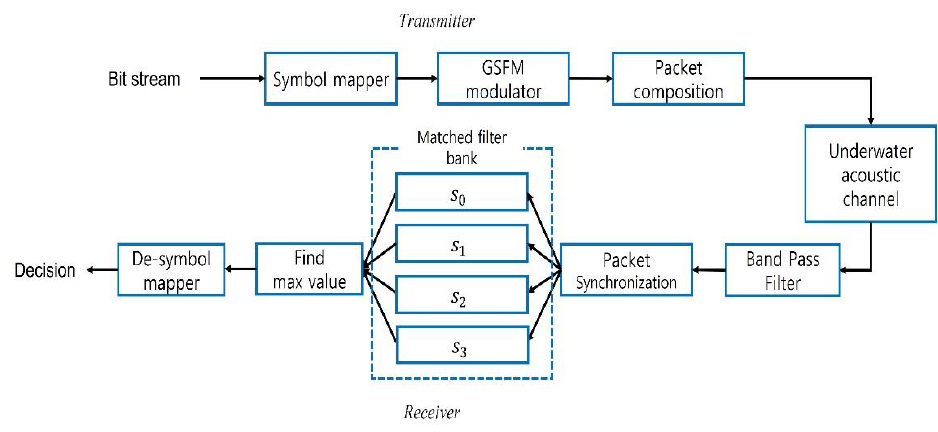
Figure 2. Block diagram of UWA communication by using GSFM waveform.